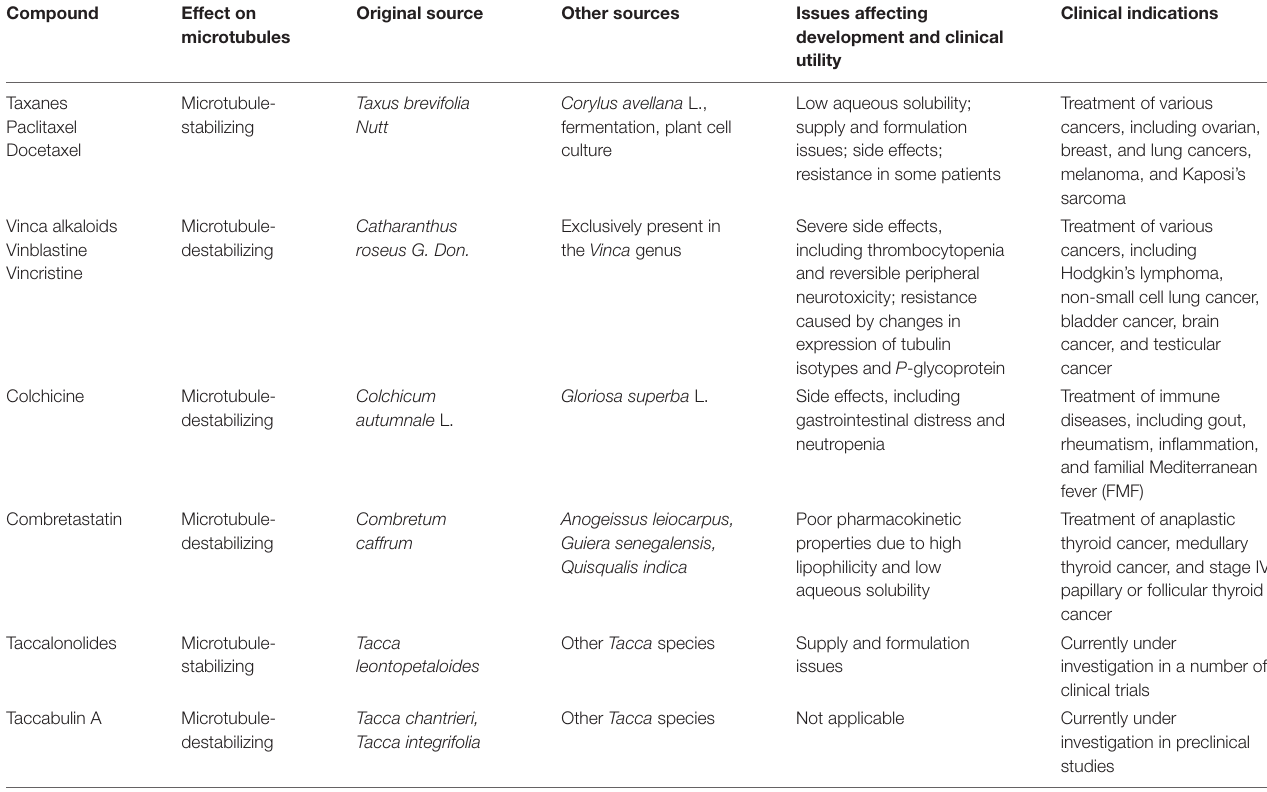
TABLE 1 | Plant-derived MTAs, their sources, and clinical